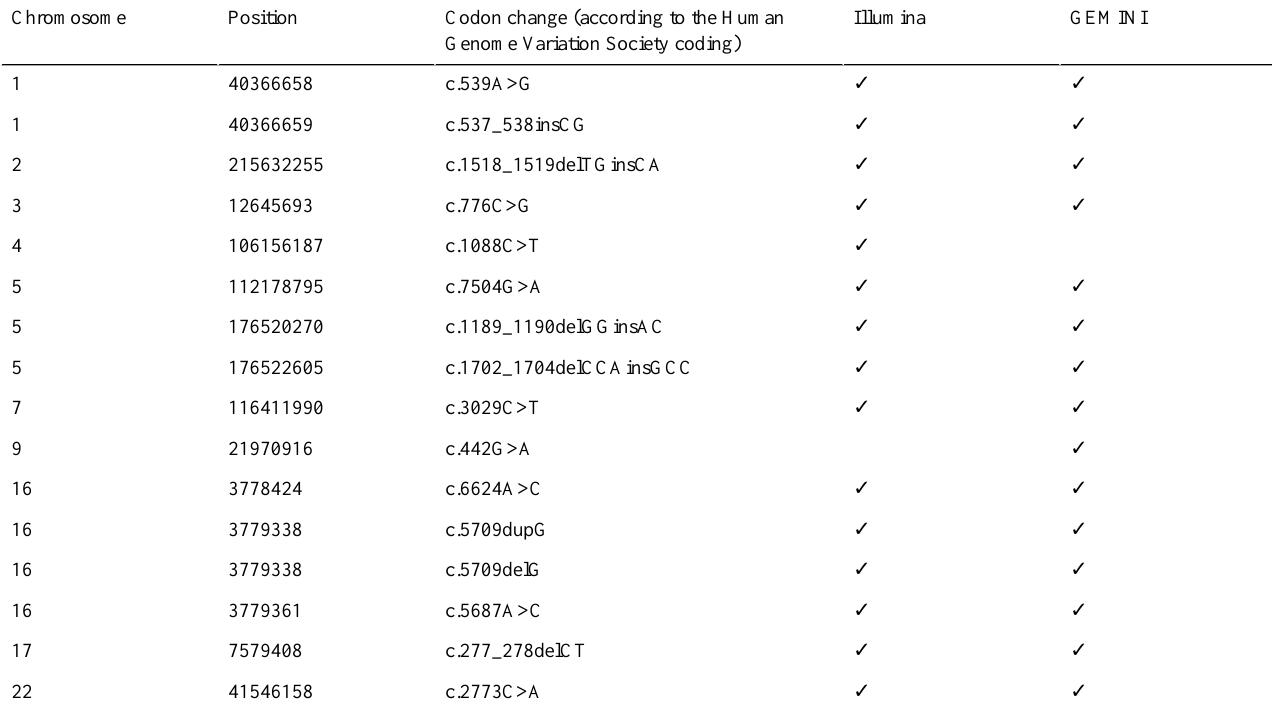
Table 2. Comparison of the filtered results of the mutations in the GEMINI (GEnome MINIng) and Illumina pipeline. GEMINIIlluminaCodon change (according to the